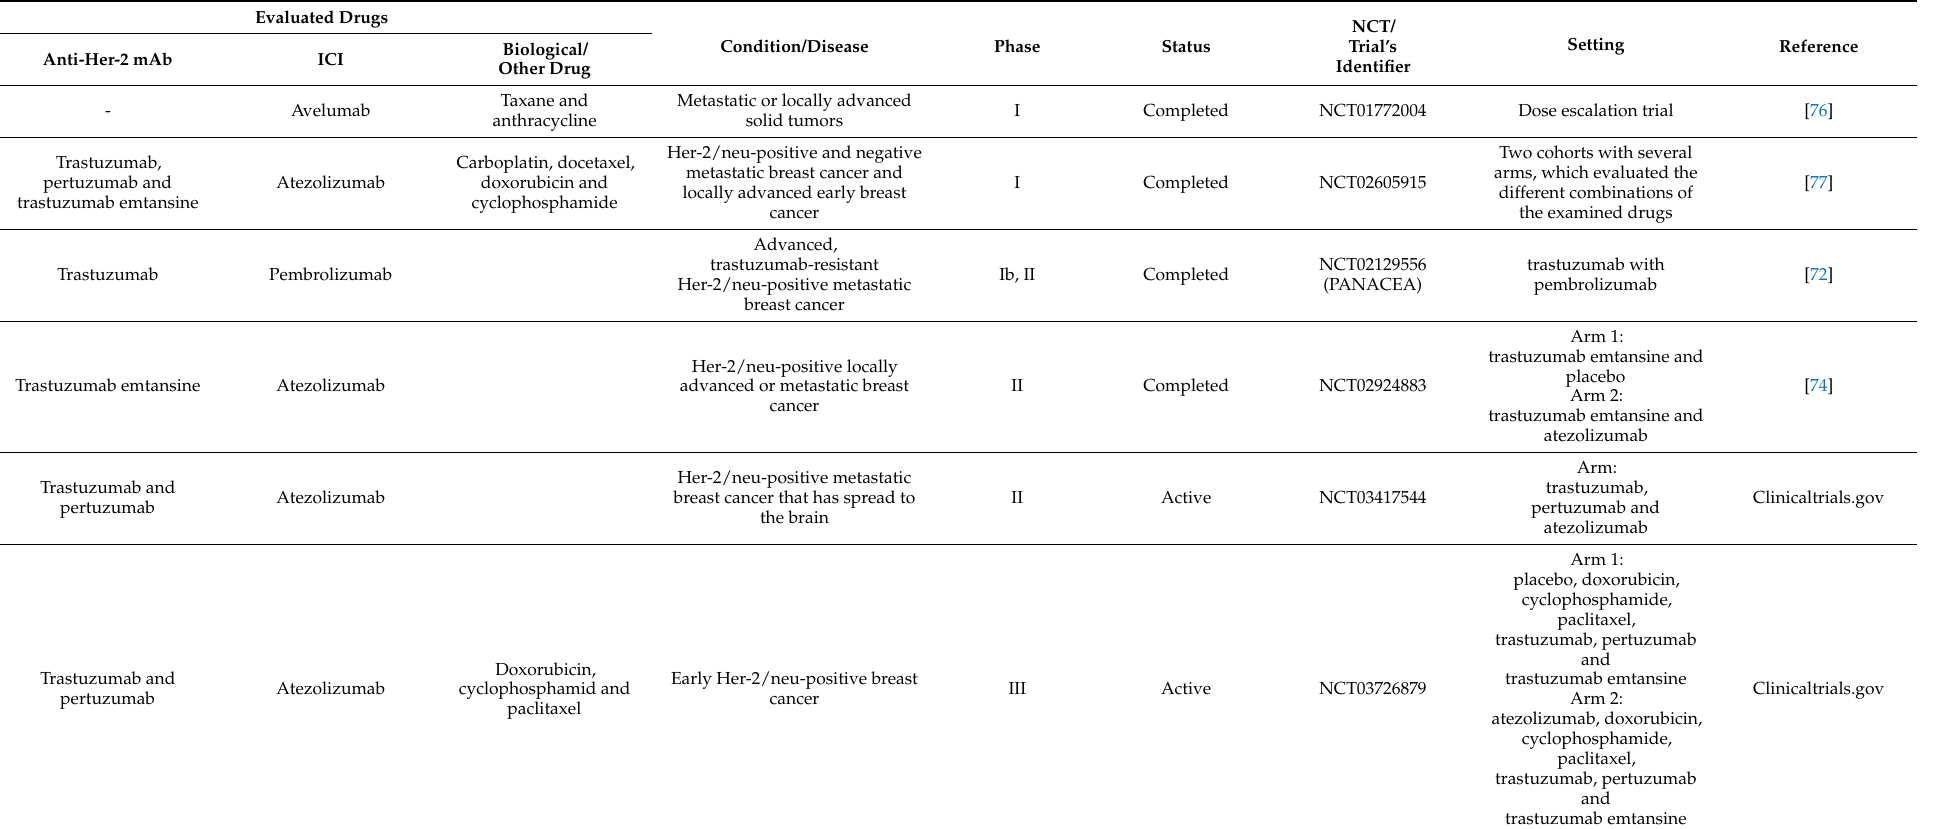
Table 1. List of main completed/active/recruiting clinical trials with ICIs and anti-Her-2/neu-targeted therapies, with or without combination with biological